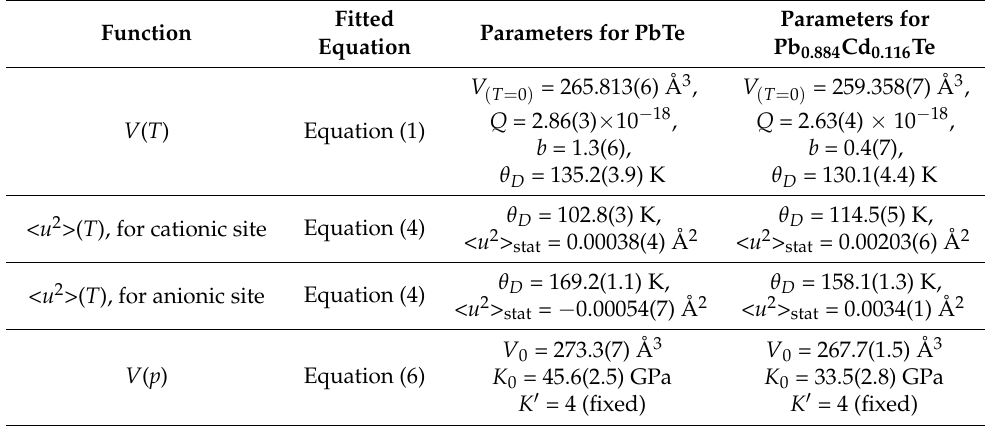
Table A5. Fitted values of the parameters of Equations (1), (4) and (6), obtained for PbTe and